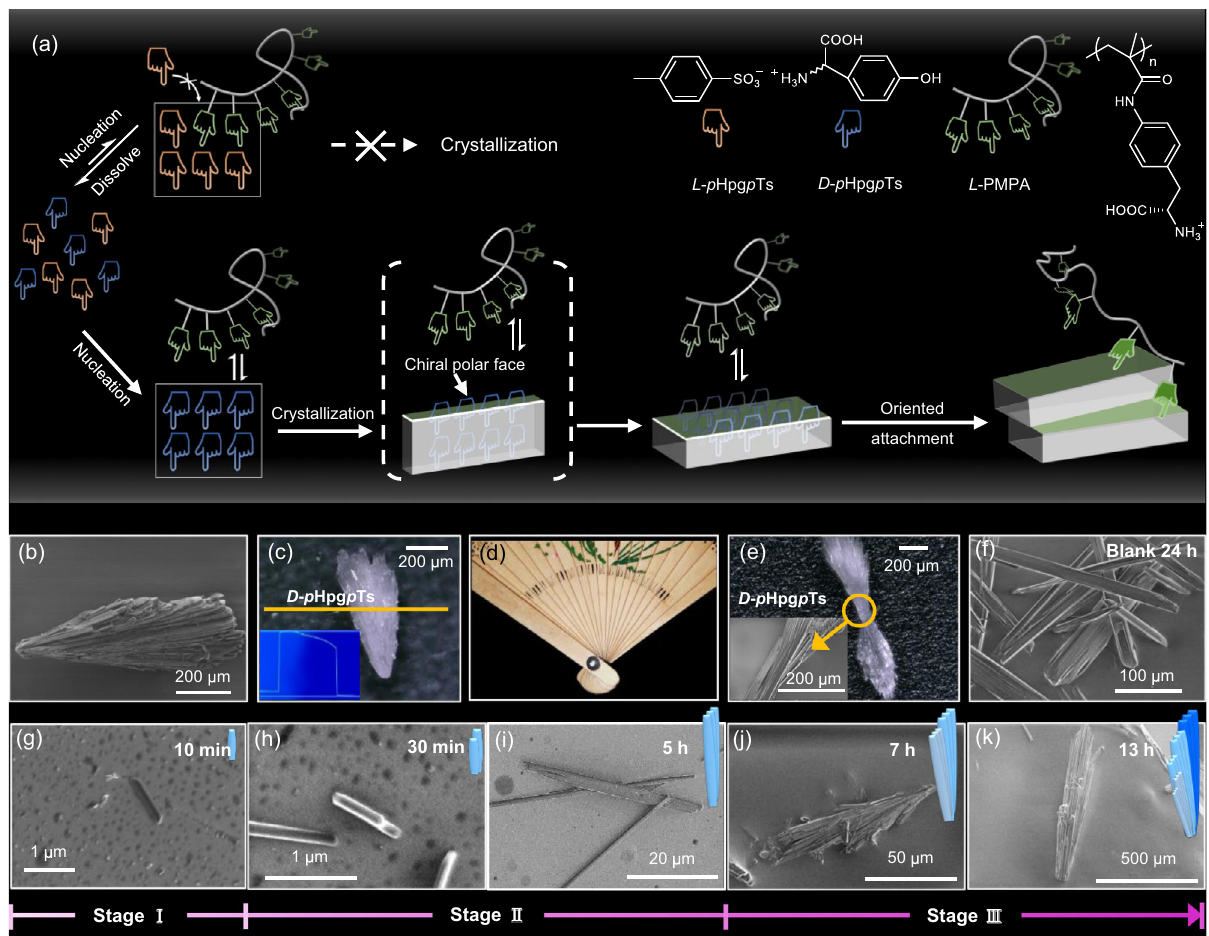
Fig. 2 The formation of hierarchically ordered chiral crystals from racemic solution. a The scheme of our strategy: L -PMPA with suitable chain length completely inhibits the nucleation and growth of L - p Hpg p Ts and in fl uences the crystal habit and oriented attachment of D - p Hpg p Ts through adsorption- desorption process. b Optical micrograph of a fan-shaped crystal aggregate of D - p Hpg p Ts when 1.5 wt % P5 was used as the additive. c Picture of one P-type fan-shaped crystal of D - p Hpg p Ts taken by an optical microscope with large depth-of- fi eld. (inserted picture: the height map of the crystal alone the yellow line). d Picture of a left-handed (P-type) folding fan. e Optical micrograph of one D- crystal with two-blade propeller morphology (inserted picture: the enlarged SEM image of the circled spot). f The typical SEM images of needle-like crystals of D/L - p Hpg p Ts obtained at 24 h when no additive was added. g – k The typical SEM images of the obtained crystals at 10 min to 13 h when 1.5 wt % P5 were used as additives. And P-type fan-shaped crystals of D - p Hpg p Ts were the only species under this